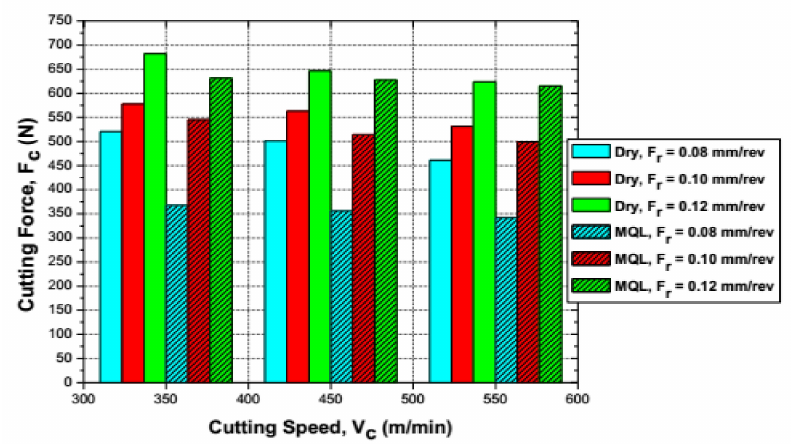
Figure 26. Effect on cutting forces by using Dry and MQL, reprinted with permission from ref. [105].